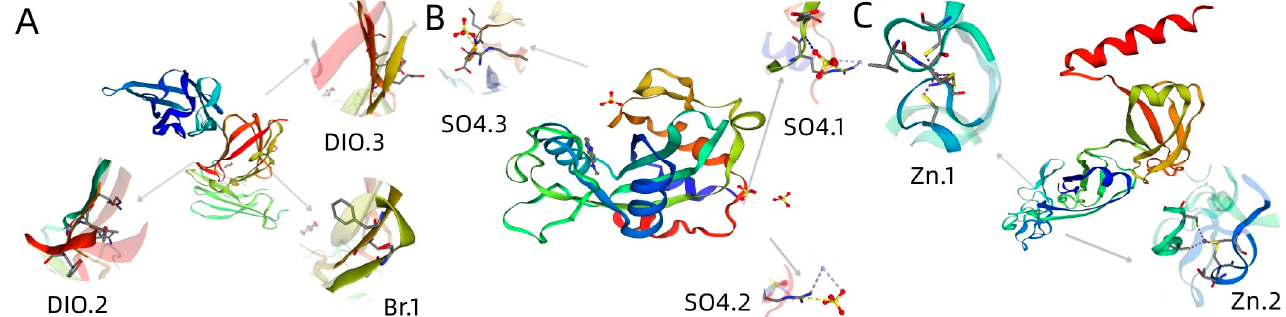
Figure 5. Homology modeling of effectors and interacting proteins. Note: ( A ): effector ApCE22 contains two DIO ligands and one Br ligand, where the DIO ligand can combine DIO ions, and Br ligand can combine Br ions; ( B ): B2 protein contains three SO 4 ligands and DCD domain (amino acids 210th to 342th), where the SO 4 ligand can be a non-polymer covalently linked to polymer or other heterogen groups; ( C ): DnaJ protein contains two Zn ligands and DnaJ domain (amino acids 43rd to 258th), where the Zn ligand can combine zinc ions.